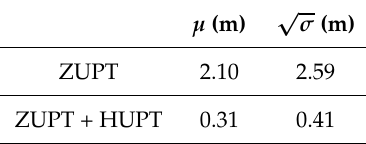
Table 1. Error in height e h